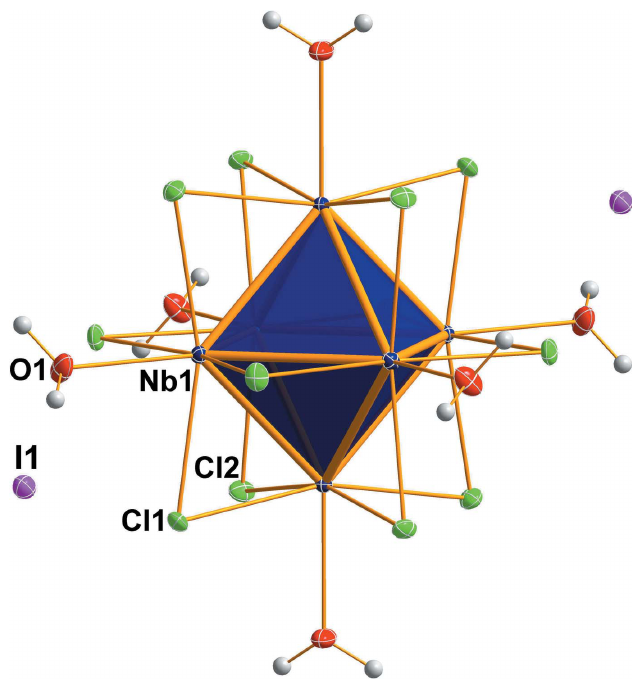
Figure 1 Perspective view of the title compound with atom labelling for the asymmetric unit. Displacement ellipsoids are shown at the 50% probability